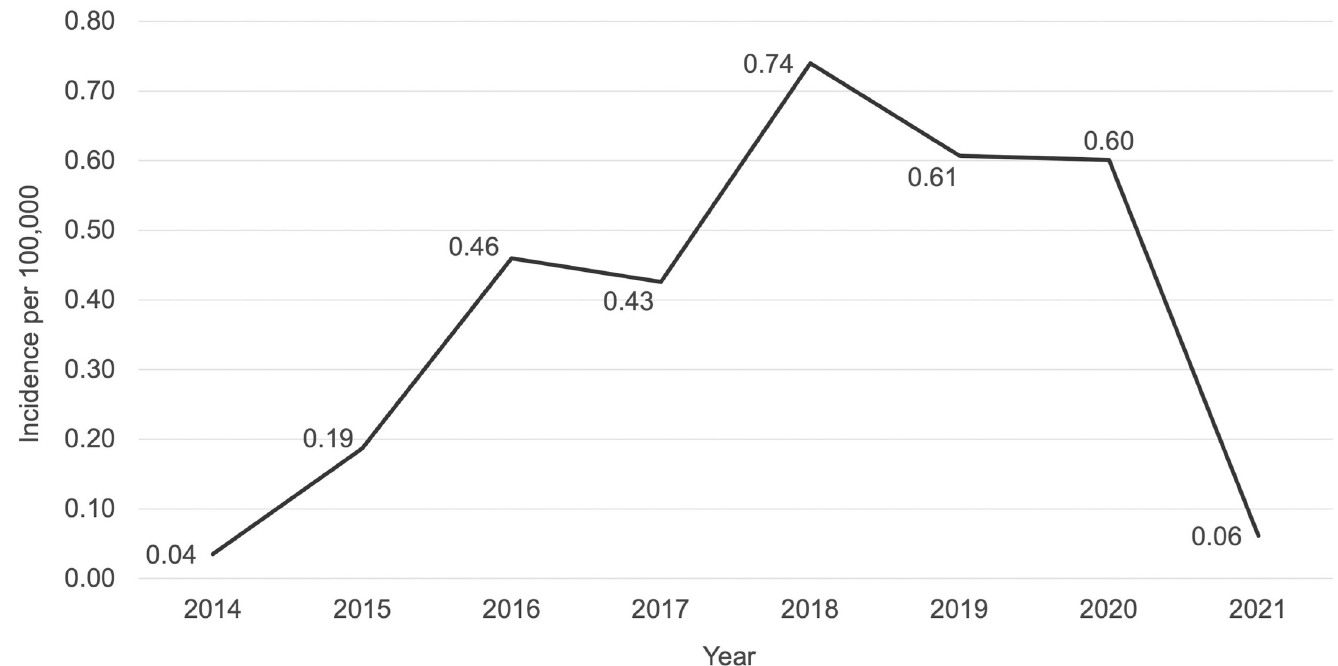
Fig 1. Average annual incidence of confirmed diphtheria cases in Haiti, December 2014 –June